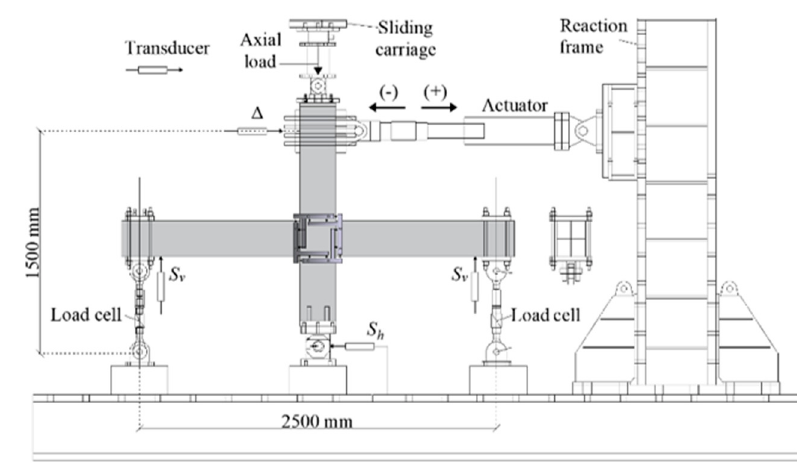
Figure 3. Schematic of the test setup.